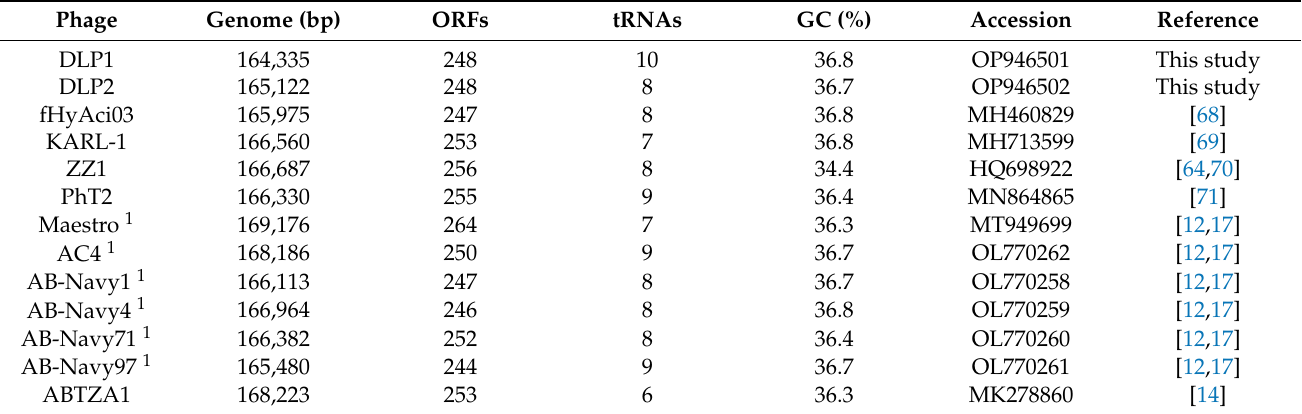
Figure 13. A heat map (% ID) of a MAFFT whole genome alignment using the Acinetobacter T4-like phages.